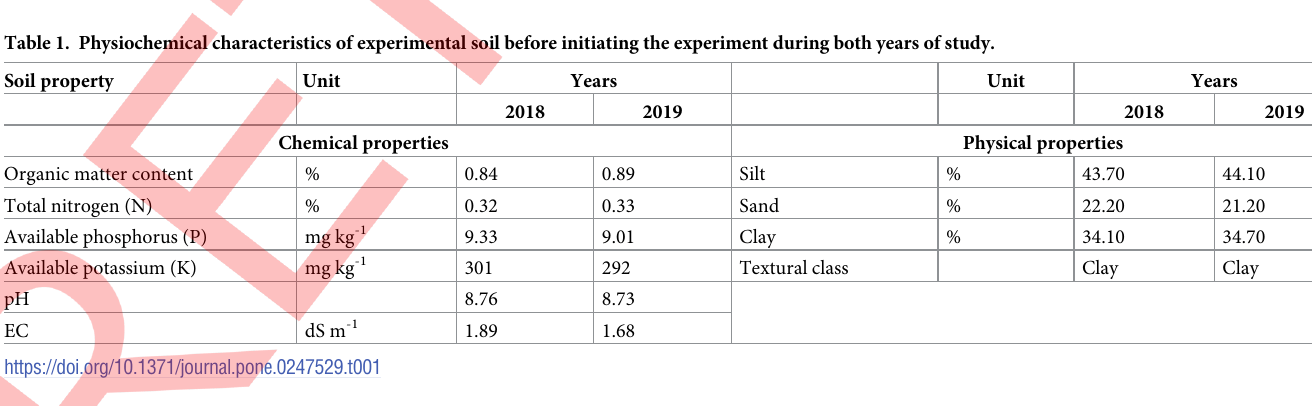
Table 1. Physiochemical characteristics of experimental soil before initiating the experiment during both years of study. Soil